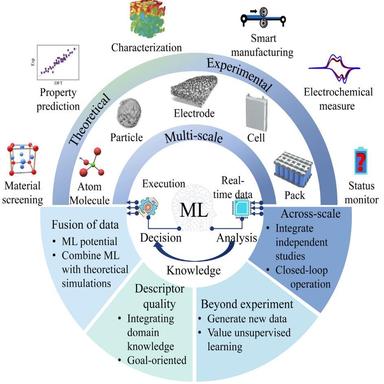
Schematic representation of future directions for ML in MIB research.